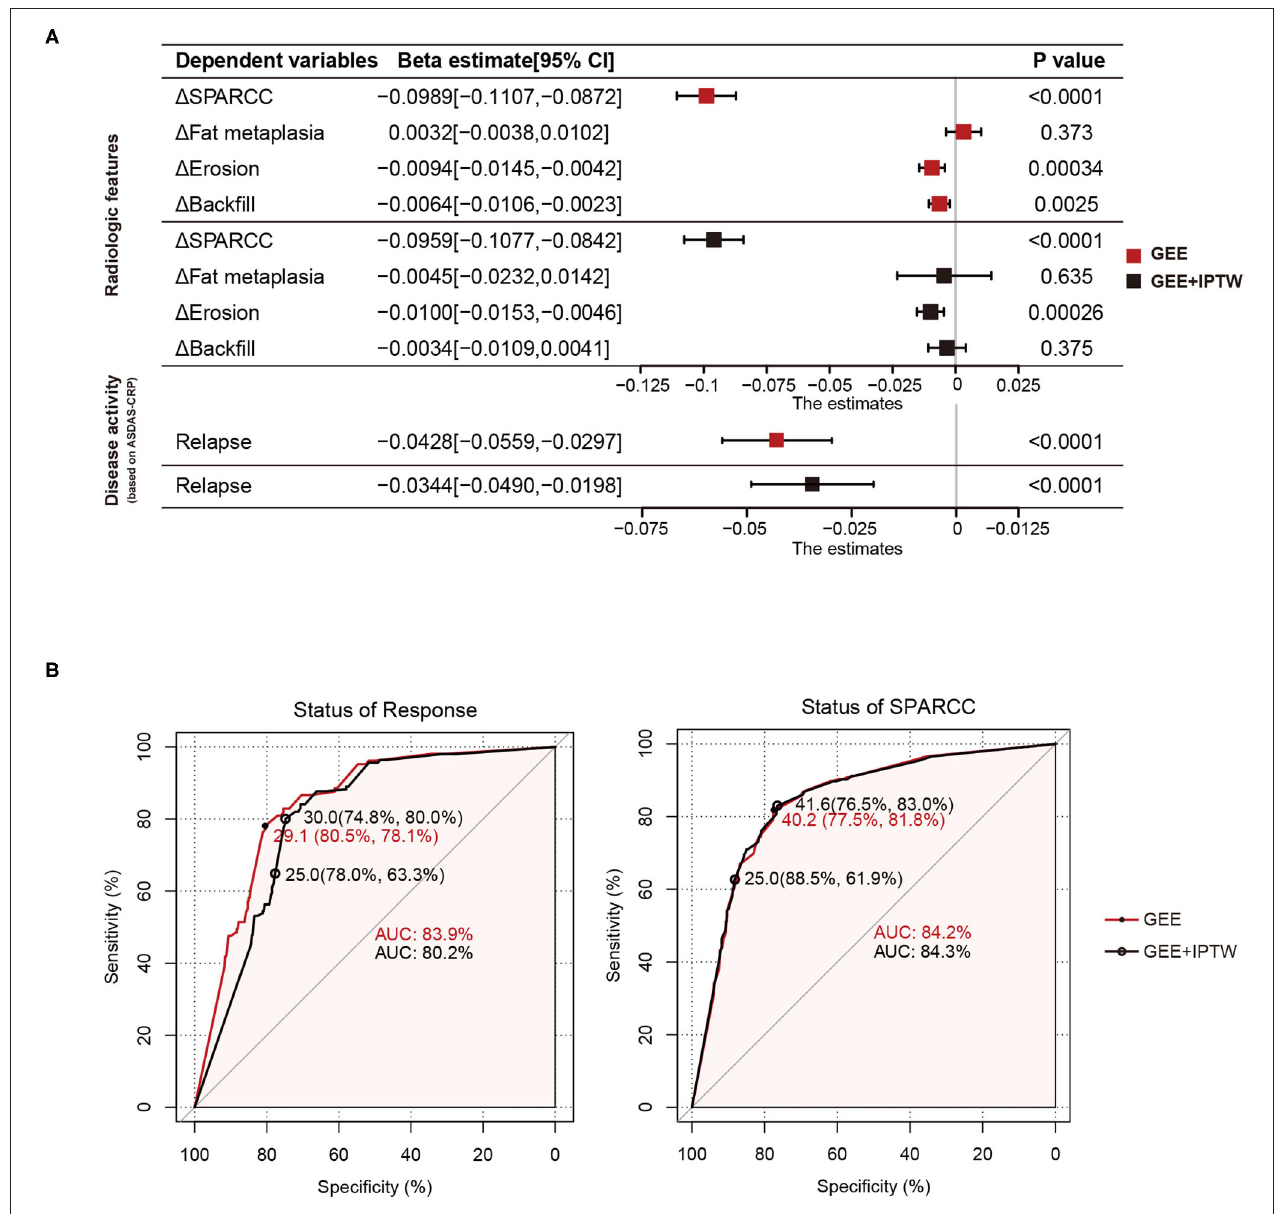
FIGURE 2 | Average DQ values of 540 intervals from 108 patients with axSpA were fitted to relapse status and MRI features (change of SPARCC, fat metaplasia, erosion, and backfill score between the end and the start of the corresponding intervals) with GEE or GEE + IPTW methods. (A) Forest plots. (B) ROC curves of average DQ value in discriminating the status of treatment response (response or relapse) and status of SPARCC (SPARCC score increased or not). DQ, dose quotient; axSpA, axial spondyloarthritis; SPARCC, the Spondyloarthritis Research Consortium of Canada; GEE, generalized estimating equation; IPTW, inverse-probability-of-treatment